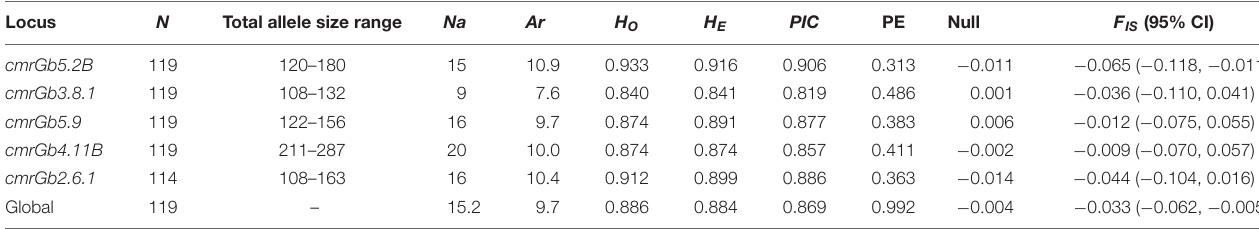
TABLE 2 | Global genetic diversity estimators by locus in all analyzed samples ( n = 153) of Genypterus chilensis in the coast of Chile using 5 SSR loci. Locus N Total allele size range Na Ar